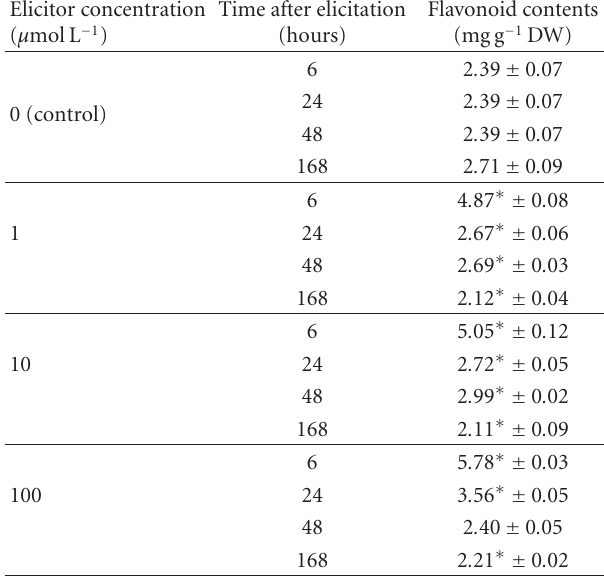
Table 2: Production of flavonoids in the suspension culture of Tri- folium pratense